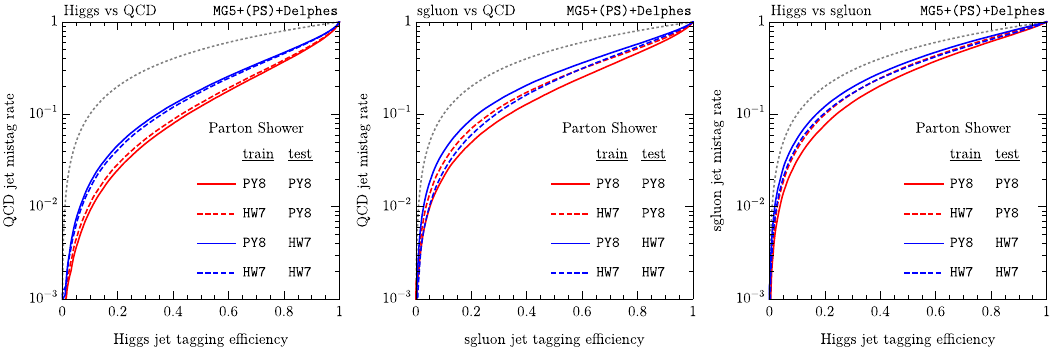
Figure 11 . The ROC curves of the MLP trained on S 2 ; trim and S 2 ; soft . The solid and dashed lines correspond to the classi(cid:12)er trained with PY8 and HW7 , respectively. The red and blue lines correspond to the classi(cid:12)er tested with PY8 and HW7 , respectively. The dashed gray lines represent the ROC curves of the random guess. We show the results of discriminating Higgs jet vs. QCD jet (left), sgluon jet vs. QCD jet (center), and Higgs jet vs. sgluon jet